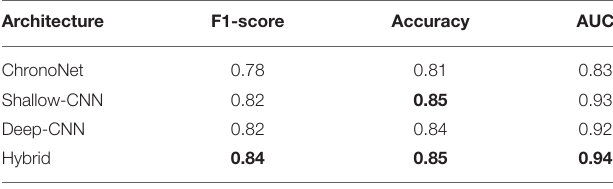
TABLE 2 | Performance of different architectures on the TUH dataset.